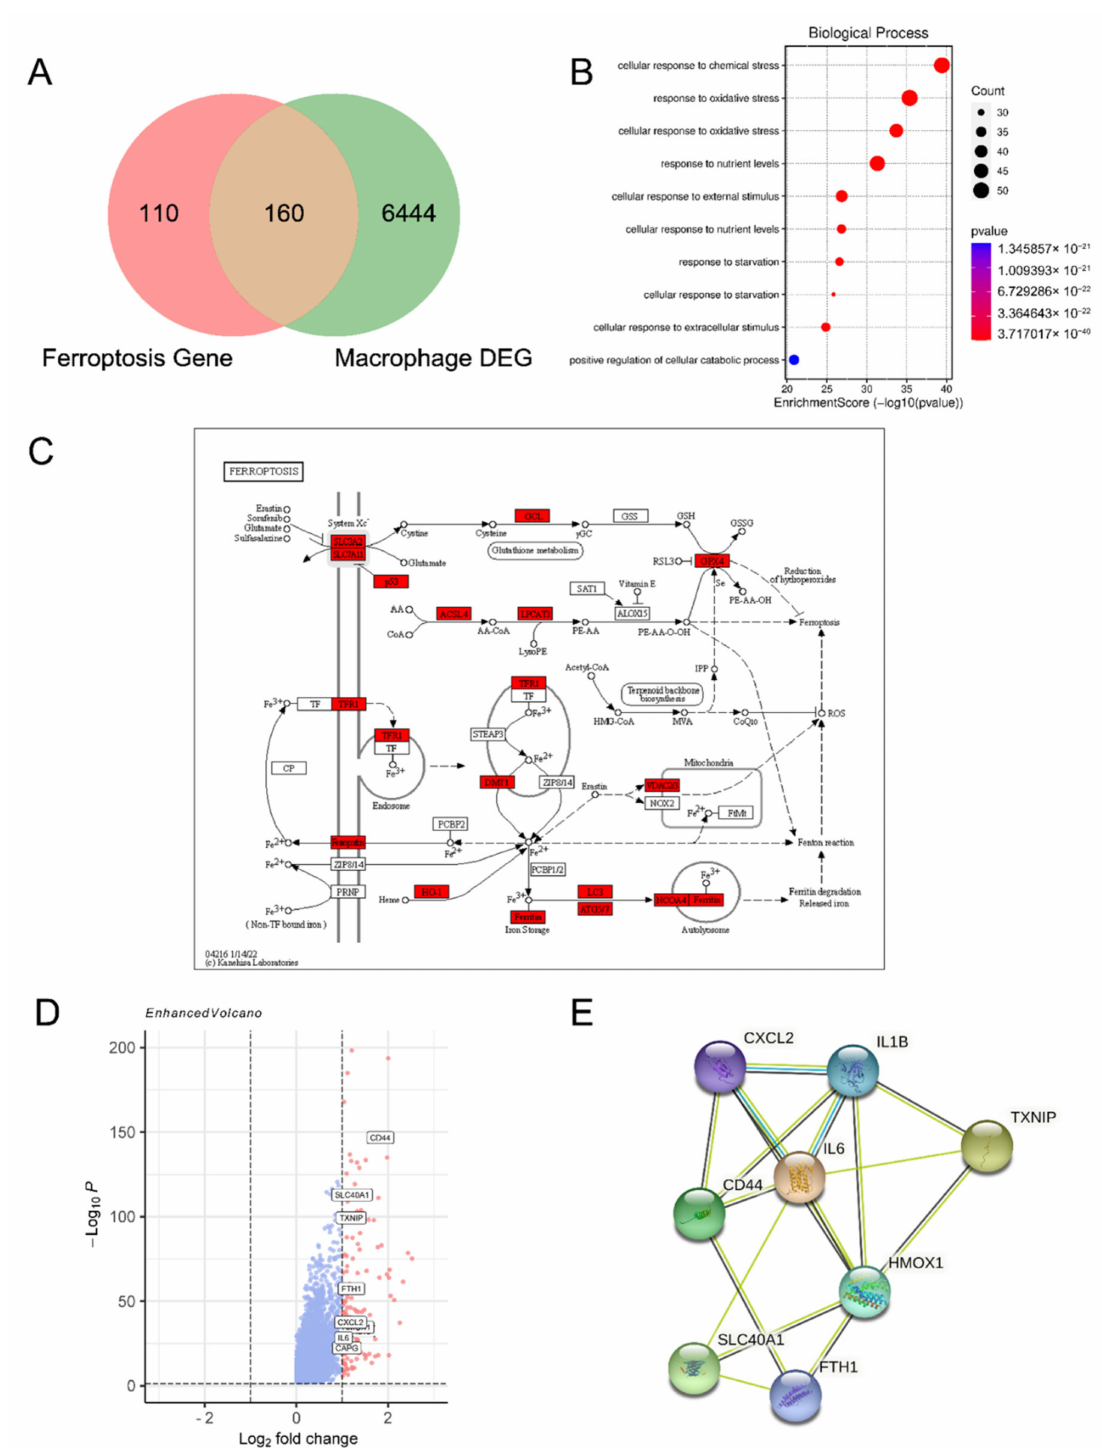
Figure 1. Identification of the ferroptosis-related genes in the macrophage of the endometriotic le- sion. ( A ) Venn diagram to identify differentially expressed ferroptosis-related genes in macrophage of endometriotic lesions. ( B ) GO analysis showed the top 10 bubble plot of DE-FRGs. ( C ) DE-FRGs were labeled in the ferroptosis pathway. ( D ) The volcano plot represented total DEGs and showed ferroptosis-related genes with thresholds of log2FC ≥ 1. The horizontal line showed a p -value of 0.05 and the vertical lines represented the default 1.0-fold change. ( E ) The PPI network downloaded from the STRING database indicated the interactions among the DE-FRGs with thresholds of log2FC ≥